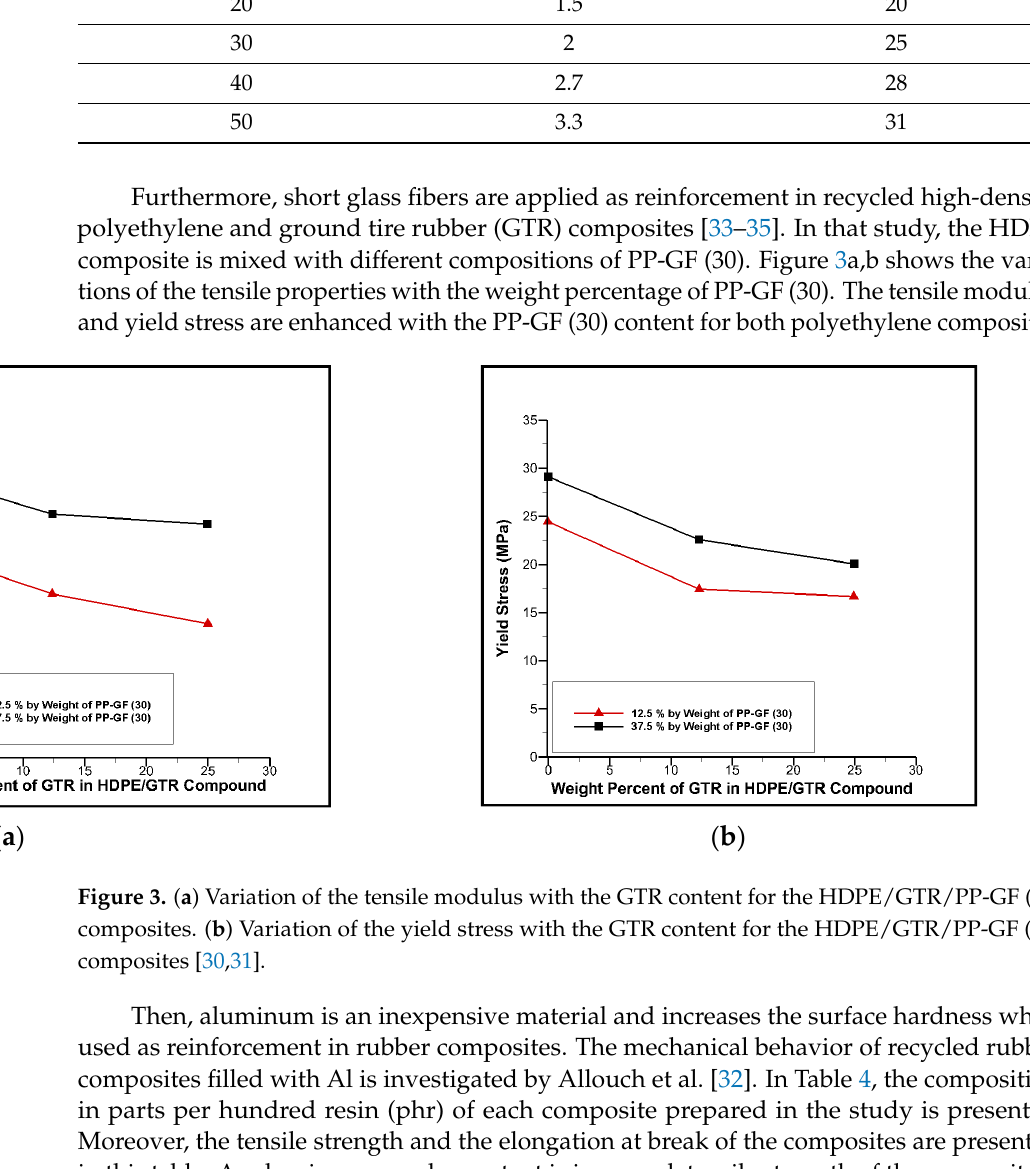
Table 4. Weight percentage of the recycled rubber reinforced polymer composites filled with aluminum powder [31].